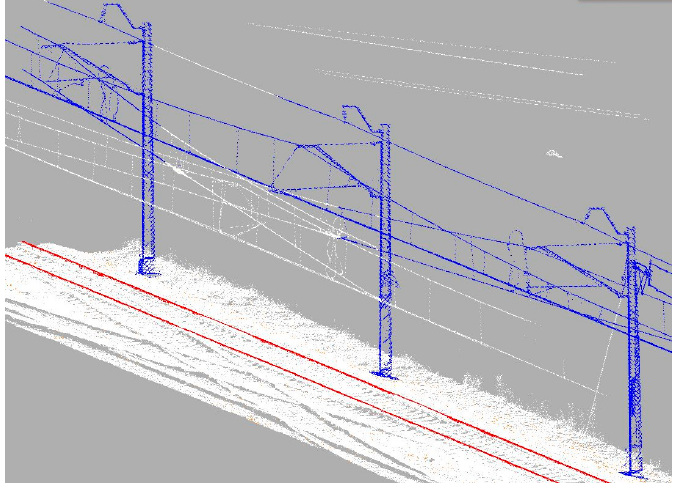
Figure 17. Part of the route including turnouts. Detected overhead contact system points in blue, rails in red, remaining points in white.